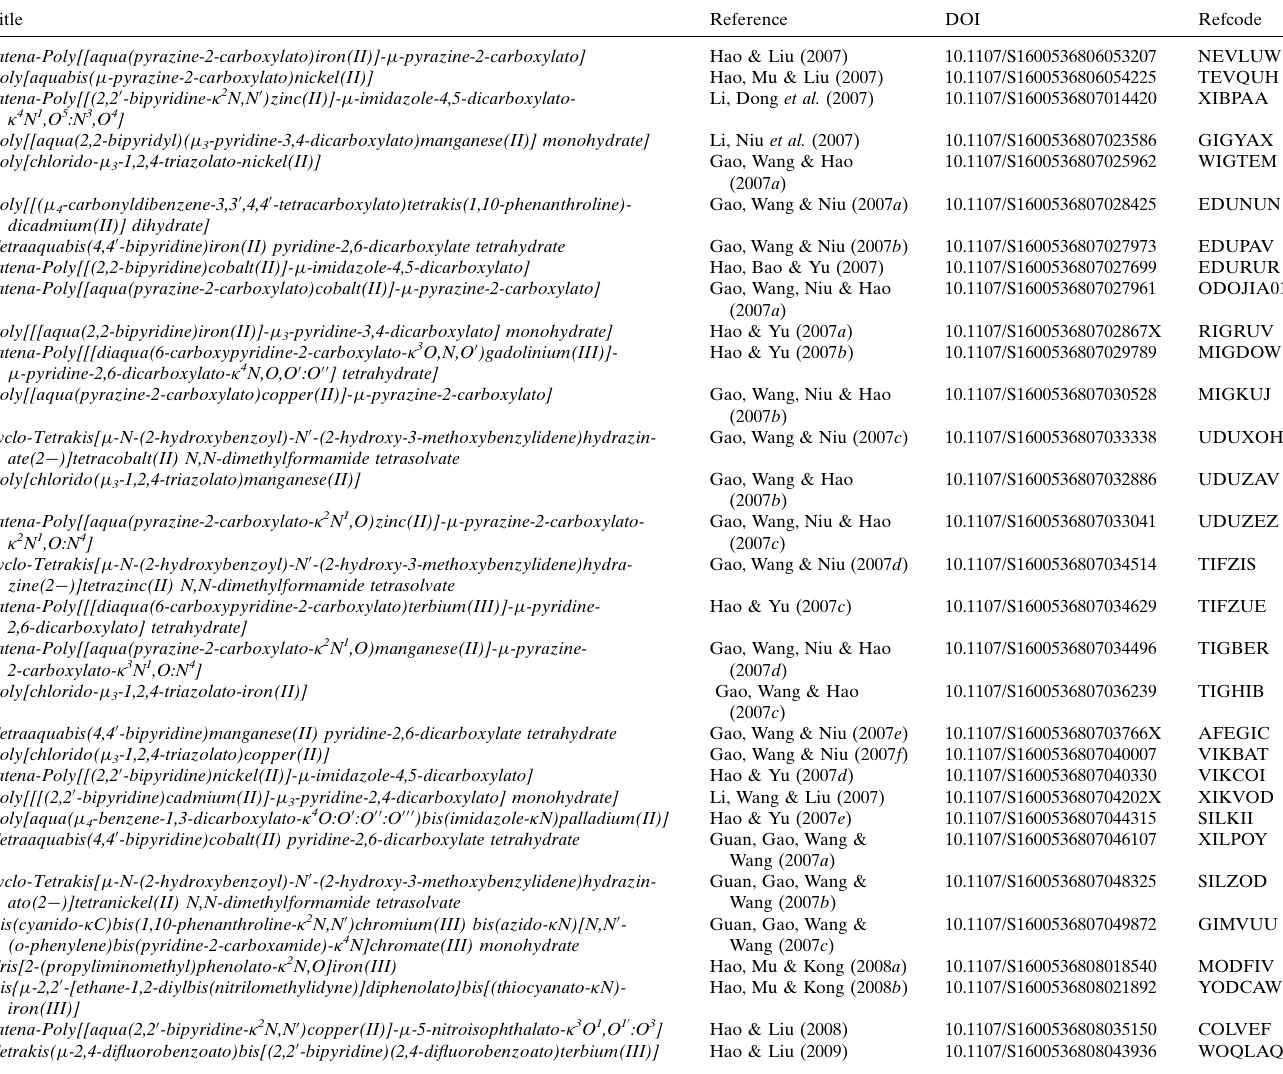
Details of articles to be retracted, in order of